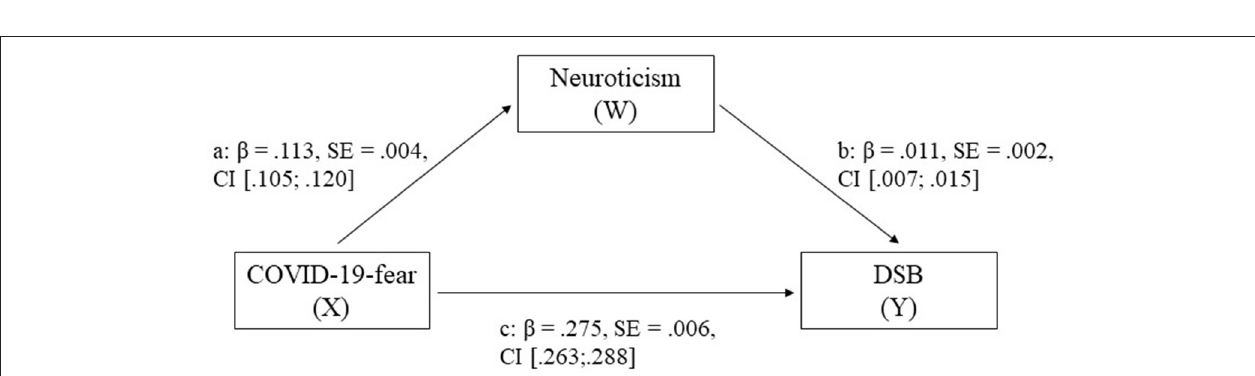
FIGURE 1 | Mediation model of neuroticism on the correlation between COVID-19-fear and adherent safety behavior (ASB). c shows the direct effect of COVID-19-fear and ASB, and a and b show the completely standardized indirect nonsignificant effects by the personality trait neuroticism.